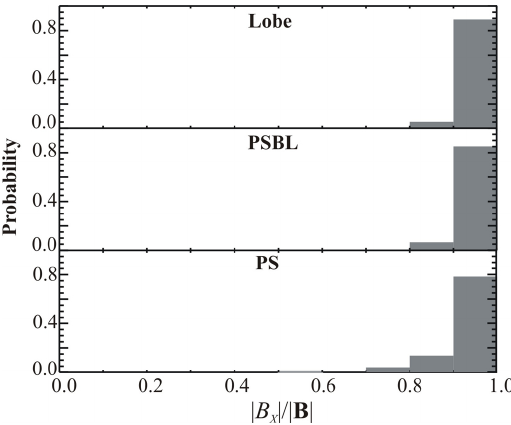
Fig. 4. Histograms of the distribution of the observation probability of | B X | / | B | values in the lobe, the PSBL and the outer PS regions.